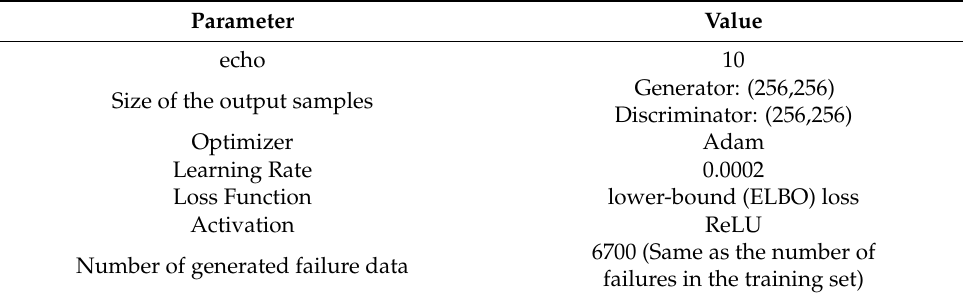
Table 5. Parameter settings for the